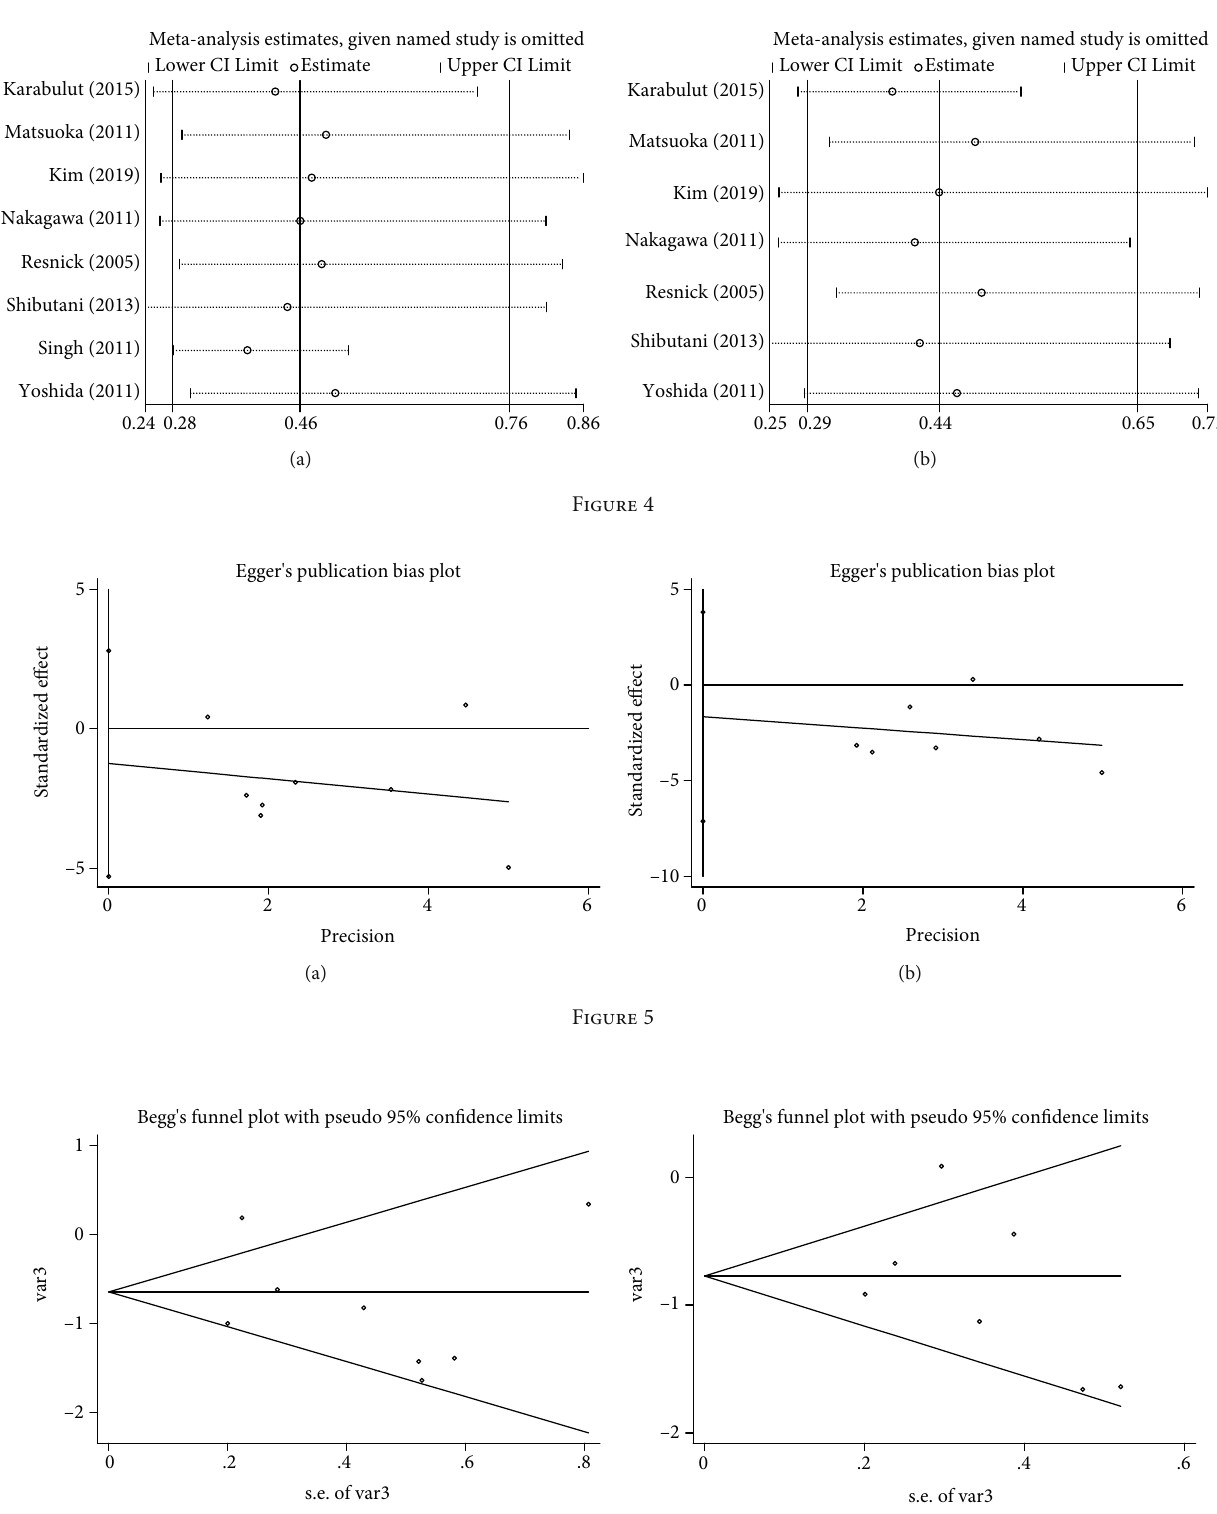
Egger's publication bias plot